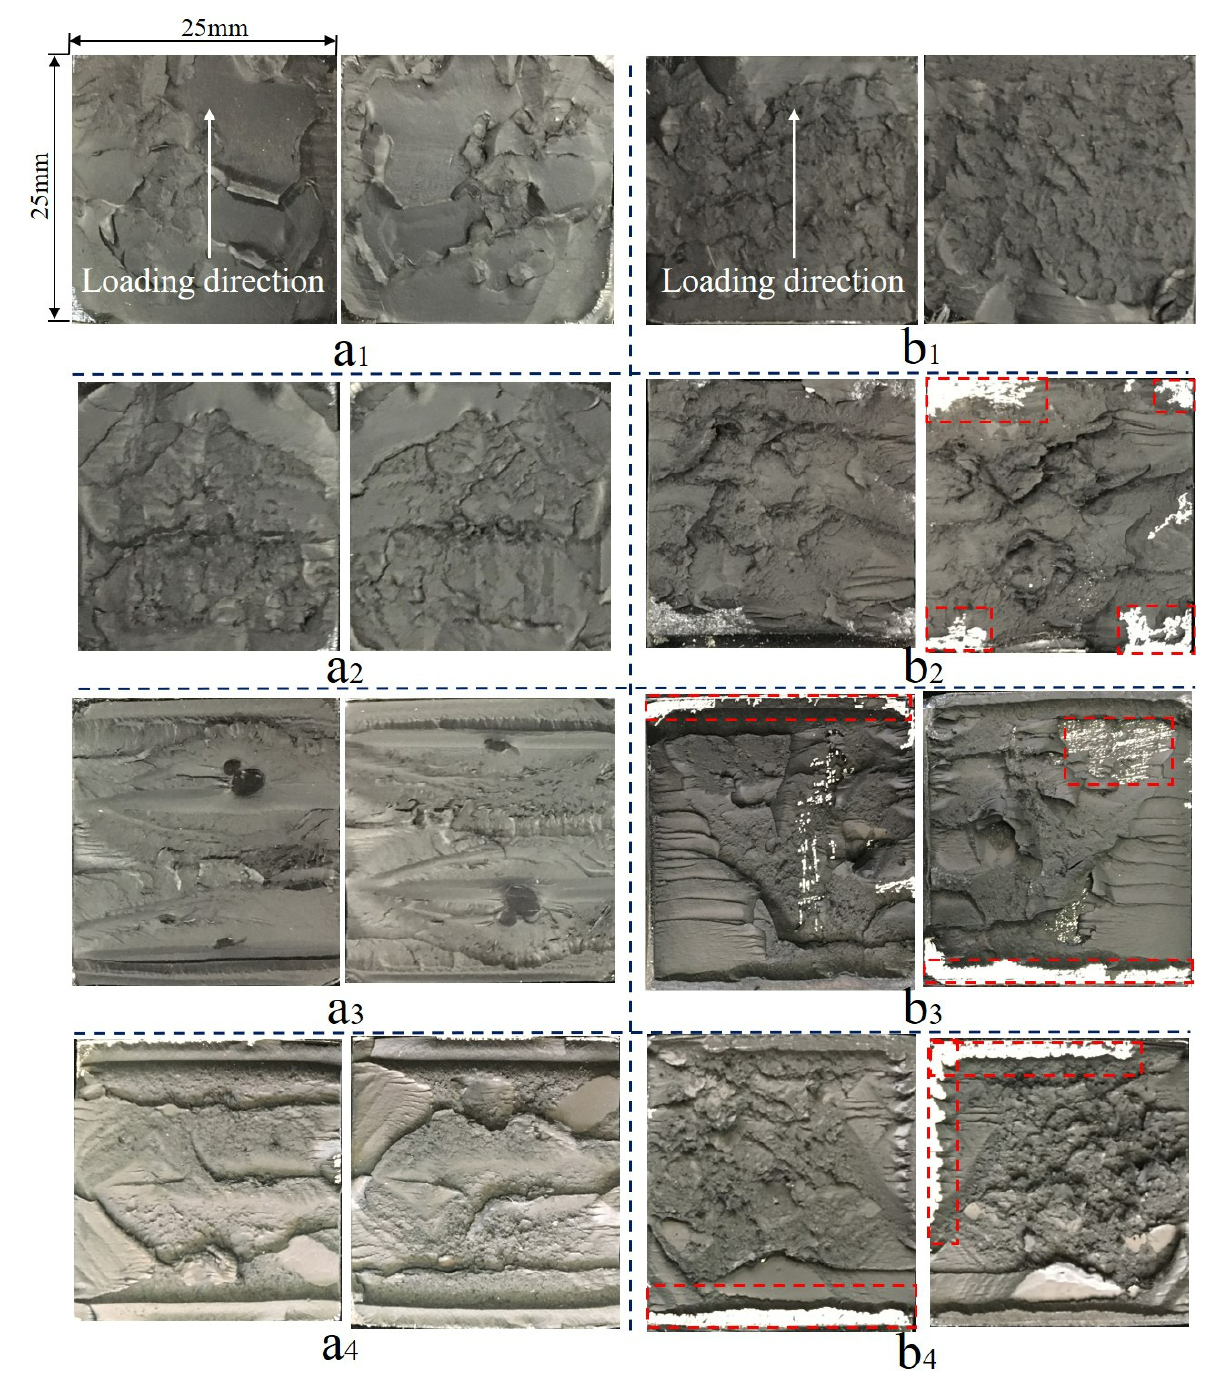
Figure 11. Macrosectional morphology: loading ( a1 ) 0 N, ( a2 ) 200 N, ( a3 ) 400 N and ( a4 ) 600 N in the HT environment; loading ( b1 ) 0 N, ( b2 ) 200 N, ( b3 ) 400 N and ( b4 ) 600 N in the HTAH environ- ment.